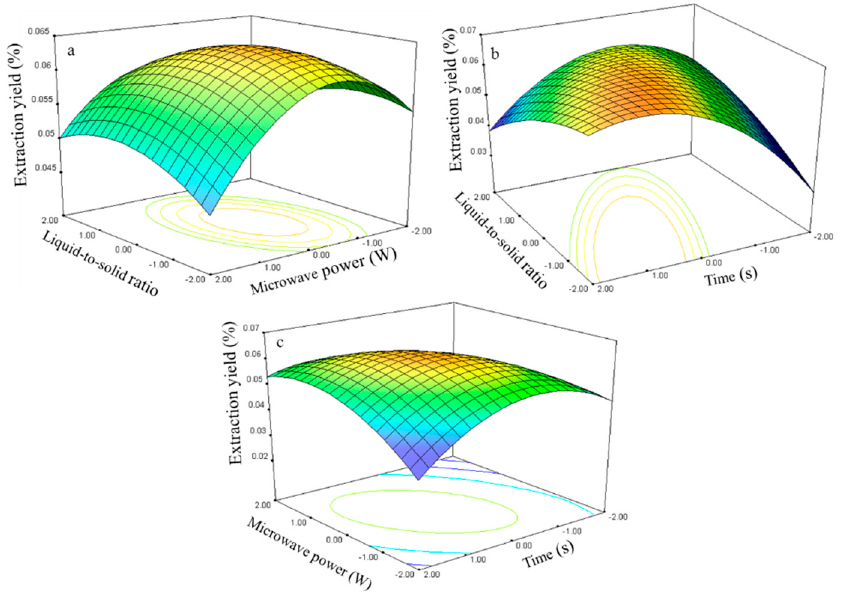
Figure 10. Response surface plots for the effects of: ( a ) liquid-to-solid ratio/power ( b ) liquid-to-solid/time ( c ) power/time on the extraction yield of kaempferol.